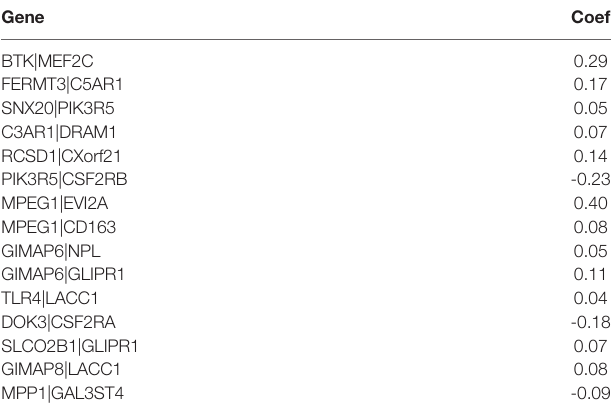
TABLE 1 | Prognostic risk scoring model information including 15 immune- related gene pairs.